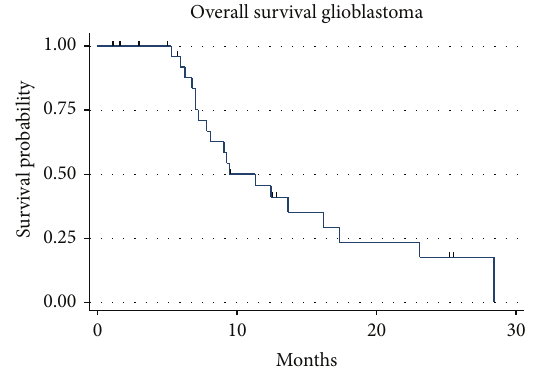
Figure 1: Kaplan Meier overall survival for all 31 patients for hypofractionated (blue line) and conventionally fractionated (red line) treatment.